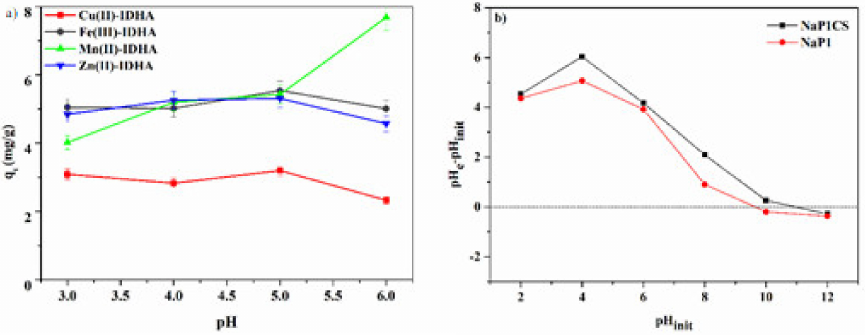
Figure 6. Influence of pH ( a ) on adsorption of Cu(II), Fe(III), Mn(II), and Zn(II) complexes with IDHA onto NaP1CS (m = 0.1 g, t = 120 min., A = 7, 180 rpm, pH = 3–6) and ( b ) pH PZC value of NaP1Cs and NaP1.